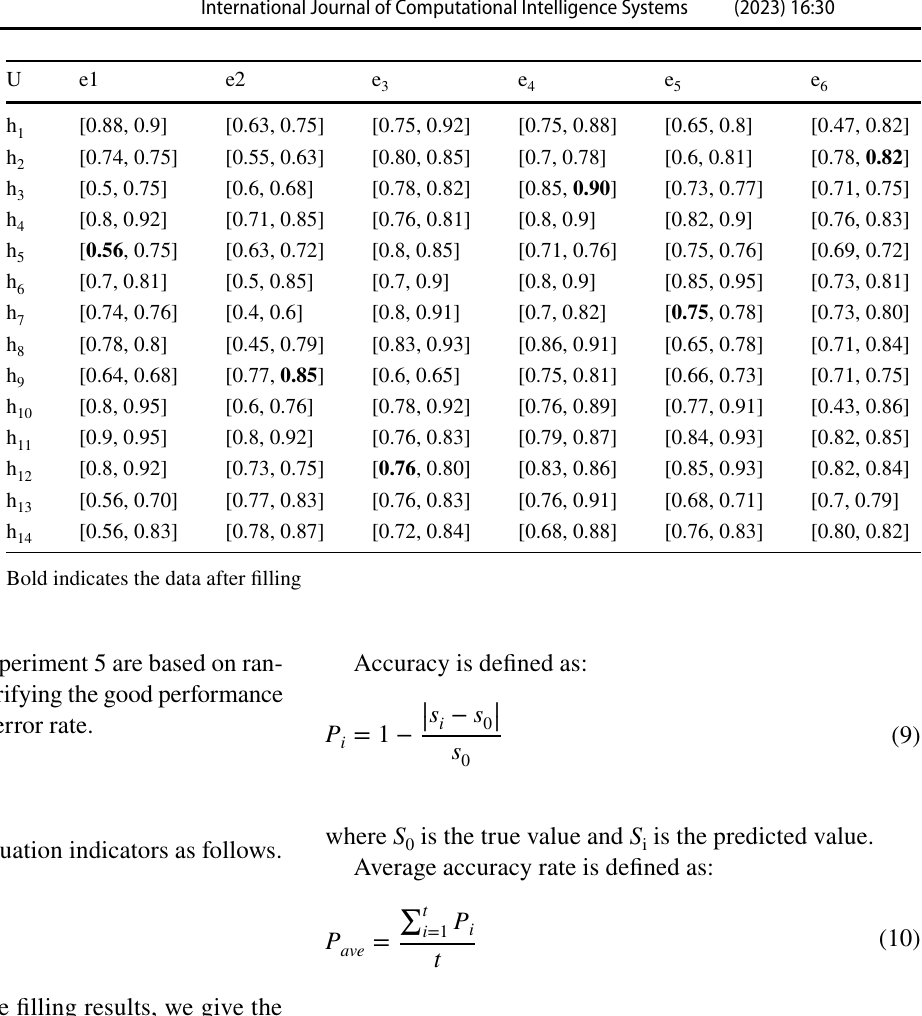
Table 6 Complete interval- valued fuzzy soft sets